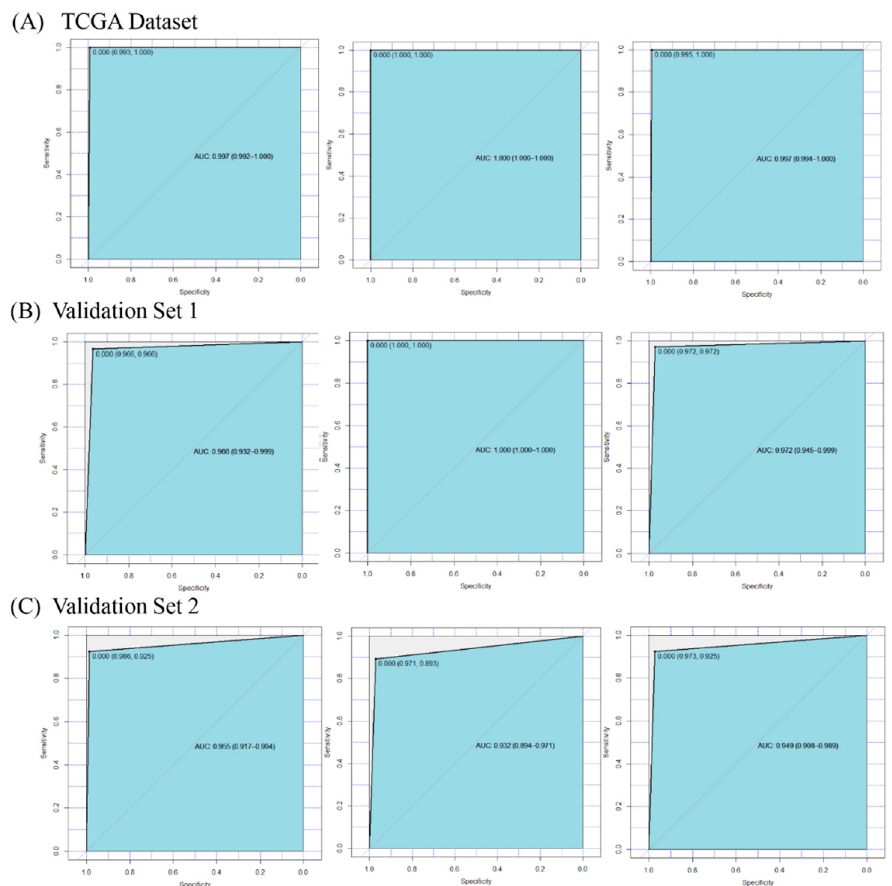
Figure 3. The receiver operating characteristic (ROC) curves and area under the curve (AUC) values for the TCGA dataset and two validation sets. ( A ) The results of the TCGA dataset, which contained 34 genes. ( B ) The results of validation set 1 (GSE39791), which included 29 genes. ( C ) The results of validation set 2 (GSE3500), which contained 23 genes. The left panel, middle panel, and right panel in picture ( A – C ) were the results of the training set, testing set, and complete set, respectively.